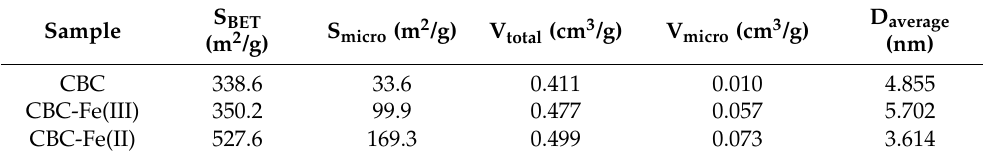
Figure 5. Magnetic hysteresis curves of CBC ‐ Fe(II). The XPS spectra of CBC ‐ Fe(II) adsorbent were obtained and are shown in Figure 6. All of the peaks of the scan survey spectra in Figure 6a were ascribed to C, O and Fe ele ‐ ments. The deconvolutions of the C1s spectra of CBC ‐ Fe(II) are shown in Figure 6b. The strongest peak located at 284.8 eV could be assigned to C–C. The other peaks at 285.2 and 285.9 eV corresponded to C–O and C=O functional groups, respectively [45]. Figure 6c represents the XPS spectra of Fe 2p. The peaks at 710.9 and 724.6 eV were respectively